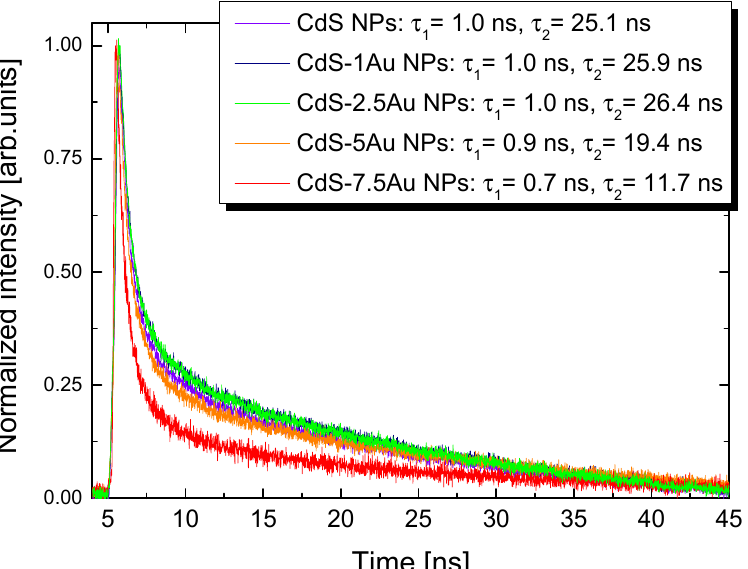
Figure 2. Photoluminescence spectra of CdS NPs showing luminescence quenching in presence of gold domains on CdS NPs’ surface.